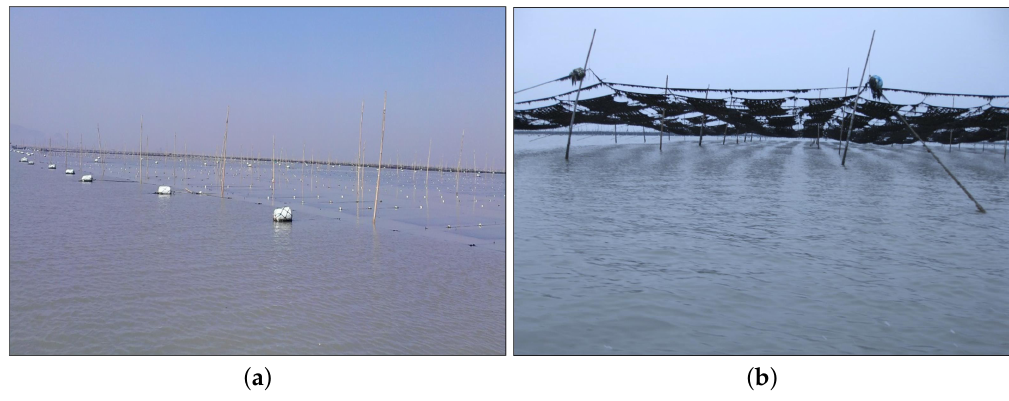
Figure 1. Raft aquaculture areas in natural environments: ( a ) Raft aquaculture species being cultivated in seawater; ( b ) Raft aquaculture species raised above the seawater surface to kill the green algal and germs on surface of the